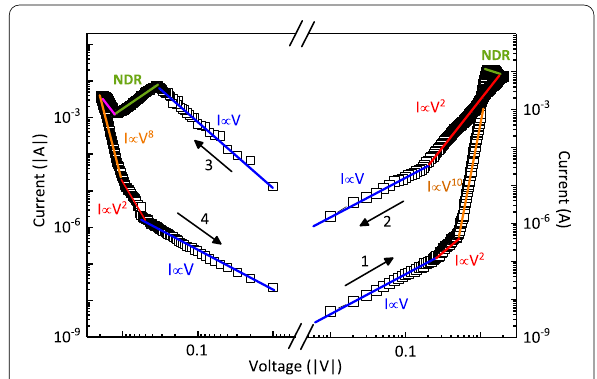
Fig. 4 The fitted lines of the double logarithmic I – V plots. The arrows indicate sweeping